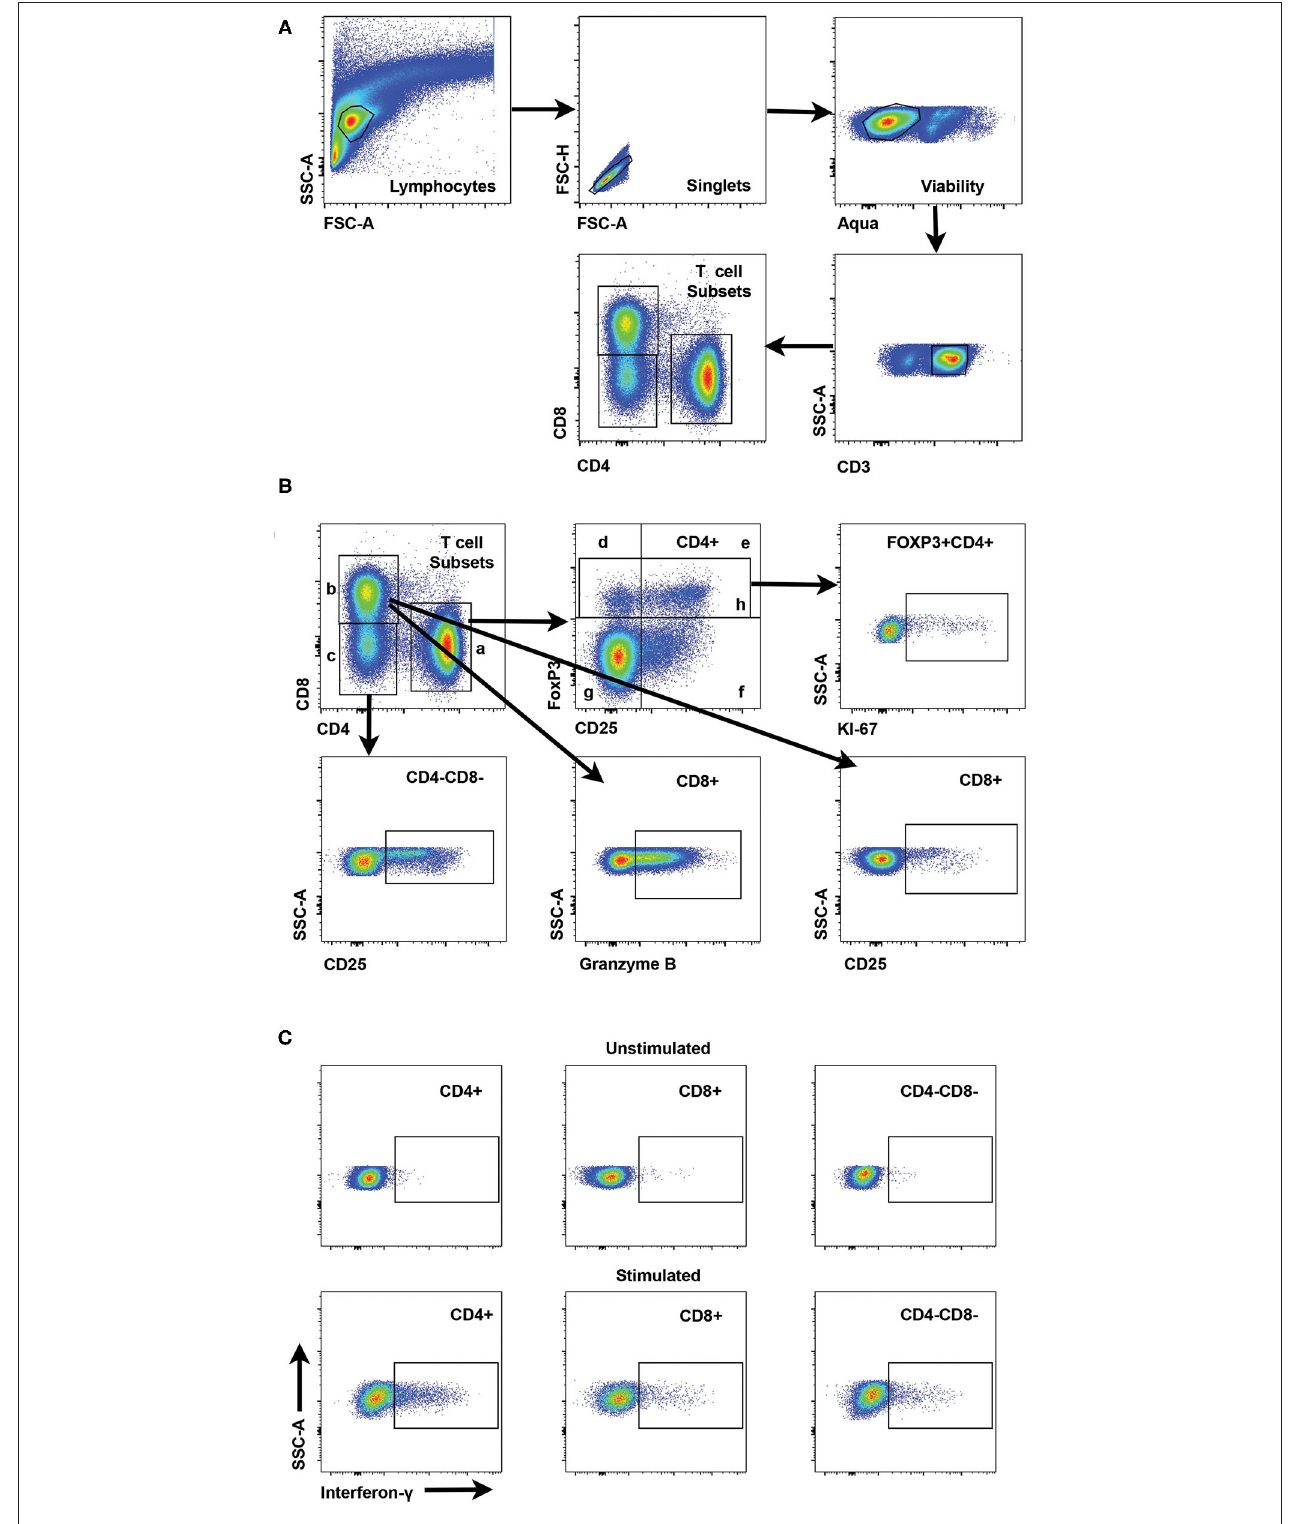
FIGURE 1 | Gating strategies for interrogation of canine T cell subsets by flow cytometry. (A) Representative scatter plots reveal the gating strategy for detection of CD4 + , CD8 + , and CD4-CD8- T cell subsets starting with establishment of a lymphocyte gate, followed by gating on singlets, exclusion of dead cells by a